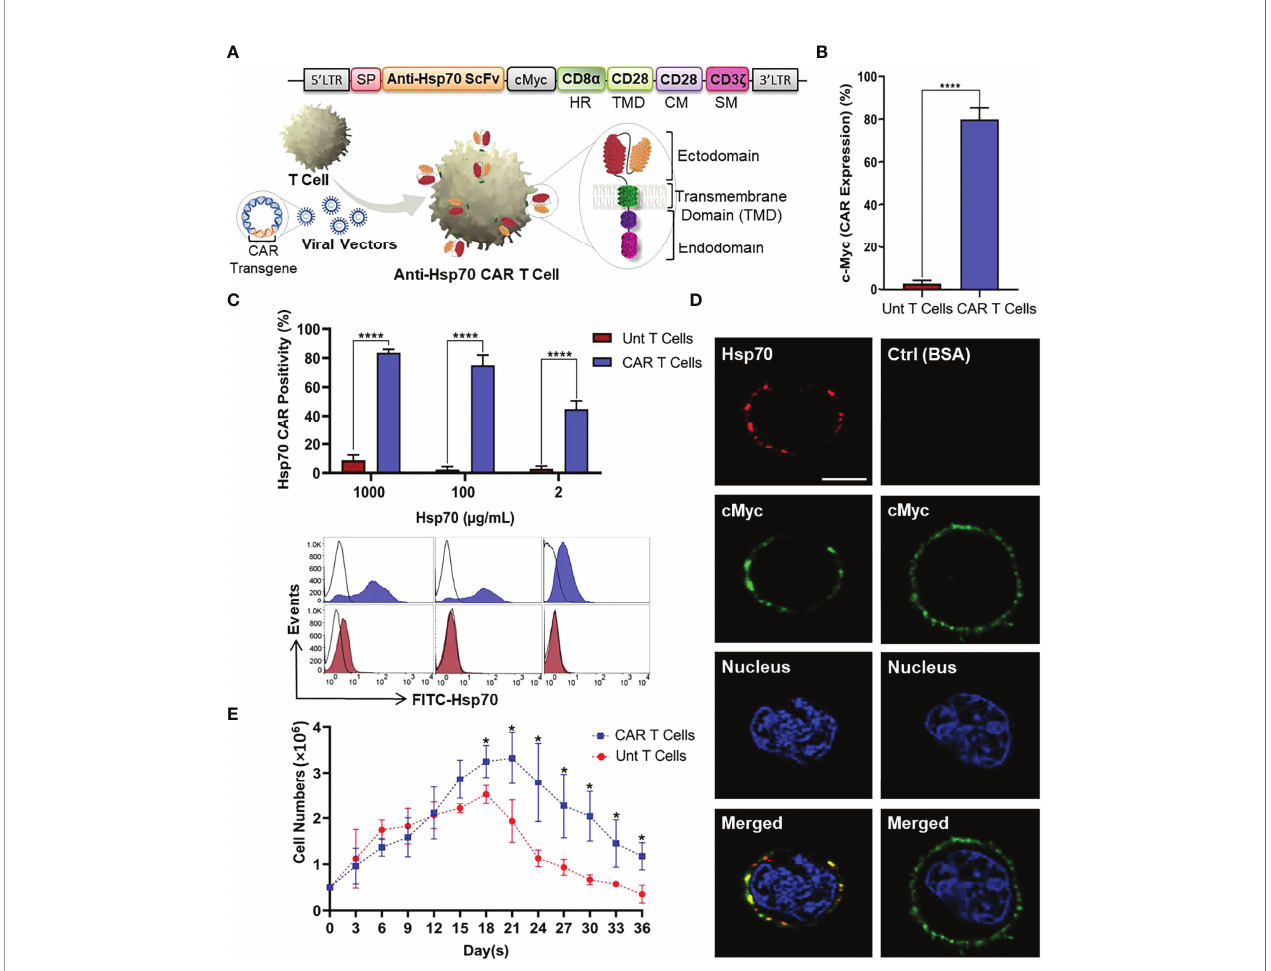
FIGURE 3 | Anti-Hsp70 CAR design and engineering of primary T cells. (A) Schematic representation of anti-Hsp70 CAR construct and retroviral transduction into T cells isolated from PBMCs. The construct comprises of an immunoglobulin heavy-chain signal peptide (SP), single-chain fragment variant (scFv) derived from cmHsp70.1 mAb, a cMyc tag, a CD8 a hinge region (HR), and a CD28 transmembrane domain (TMD) linked to an endodomain containing CD28 co-stimulatory moiety (CM) and CD3 z signaling moiety (SM). (B) Anti-Hsp70 CAR transduction ef fi ciency in T cells was analyzed by fl ow cytometry based on the detection of the cMyc tag by incubating untransduced (Unt) T and CAR T cells with FITC-cMyc mAb. An isotype-matched control mAb was used for setting gates. (C) The binding of Hsp70 protein by CAR T cells was evaluated using fl ow cytometry by incubating cells with FITC-Hsp70 (1000, 100, and 2 µg/mL). The bar chart shows the percentage of CAR-enriched T cells recognizing Hsp70 protein compared to Unt T cells. Histograms display the representative fl ow cytometry data. FITC-bovine serum albumin (BSA) was used to set the gates. The complete kinetic analysis of CAR Hsp70 protein interactions is provided in Figure S3 . (D) Anti-Hsp70 CAR expression on transduced T cells was detected by confocal microscopy using Alexa Fluor ™ 555-Hsp70 protein (Red) compared to cells incubated with Alexa Fluor ™ 555-BSA (Red). Expression of the cMyc tag was detected using the FITC-conjugated mAb (Green). Nuclei were stained with DRAQ5 ™ (blue). The co- localization of Hsp70 binding and cMyc expression in the merged images appears in yellow due to overlapping green and red signals. The scale bar is 3.7 µm. (E) The expansion and viability of untransduced T and anti-Hsp70 CAR T cells were compared in a parallel culture. After seeding (5x105 cells/well), cell proliferation was determined based on viable cell counts at three-day intervals up to 36 days. Day zero of the experiment was started on the fi rst day after removing the beads and adding to the well. Data are shown as the mean of n ≥ 3 independent donors ± SD (*p ≤ 0.05, ****p ≤